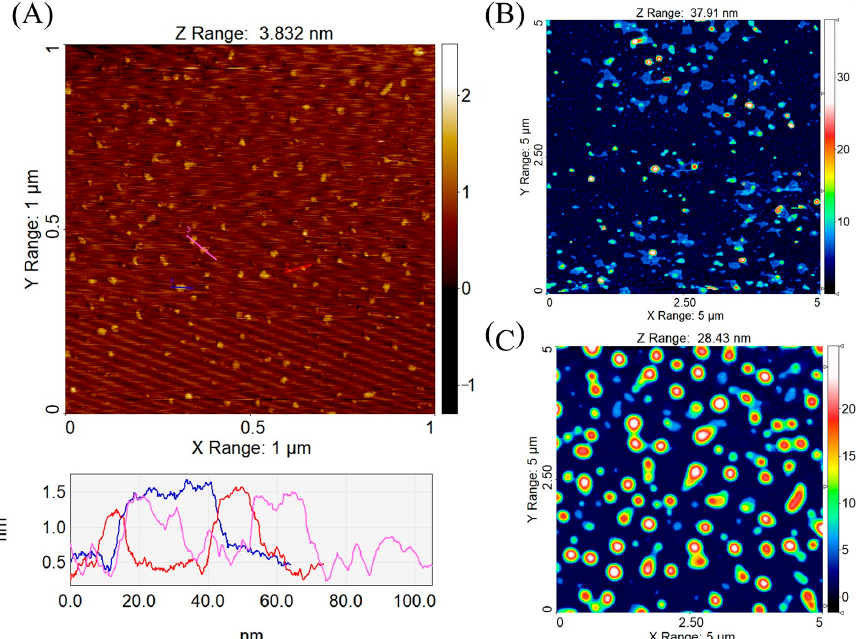
Figure 3. Atomic force microscopy (AFM) topography images of structures absorbed in air on mica: ( A ) OND—the height profile corresponds to three colored sections in the graph below the image, ( B ) dimethyldioctadecylammonium bromide (DDAB)-OND complex and ( C ) 1,2-dioleoyl-3- trimethylammonium propane (DOTAP)-OND complex, with both complexes prepared at a charge ratio 3:1 (cationic lipid:OND).